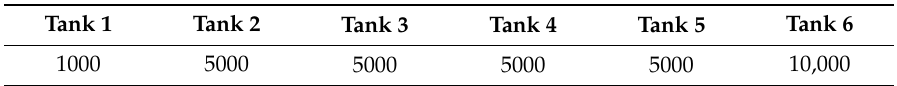
Table 3. Cost function weighting of accumulated overflow volum W , showing a higher cost for upstream tank modules discharging to the sensitive creek.